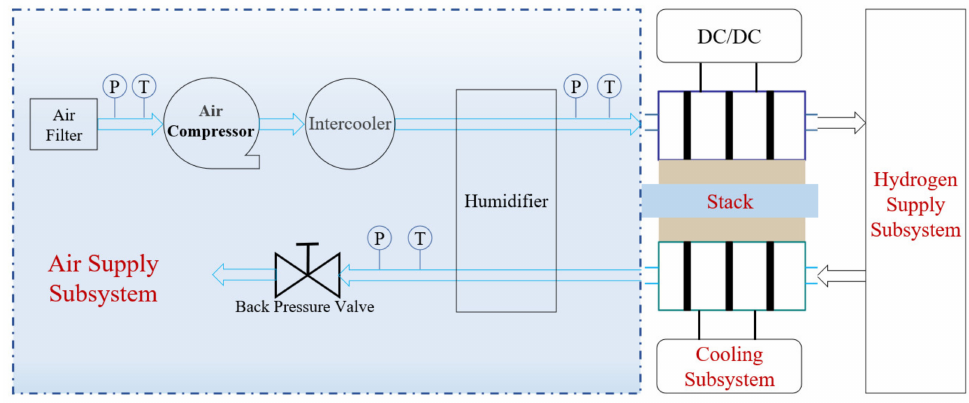
Figure 1. PEMFC system